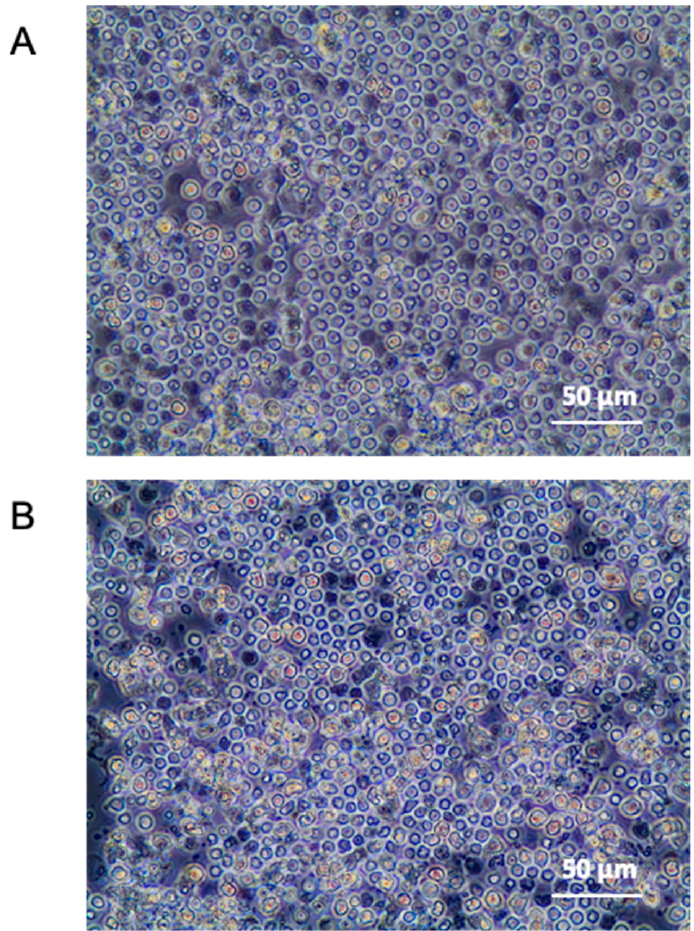
Figure 1. Representative morphology of PBMC cultured for 24 h in ( A ) normoxic (5% CO 2 , 95% air) and ( B ) hypoxic (5% CO 2 , 2% O 2 , 93% N 2 ) conditions. Magnification 200×.